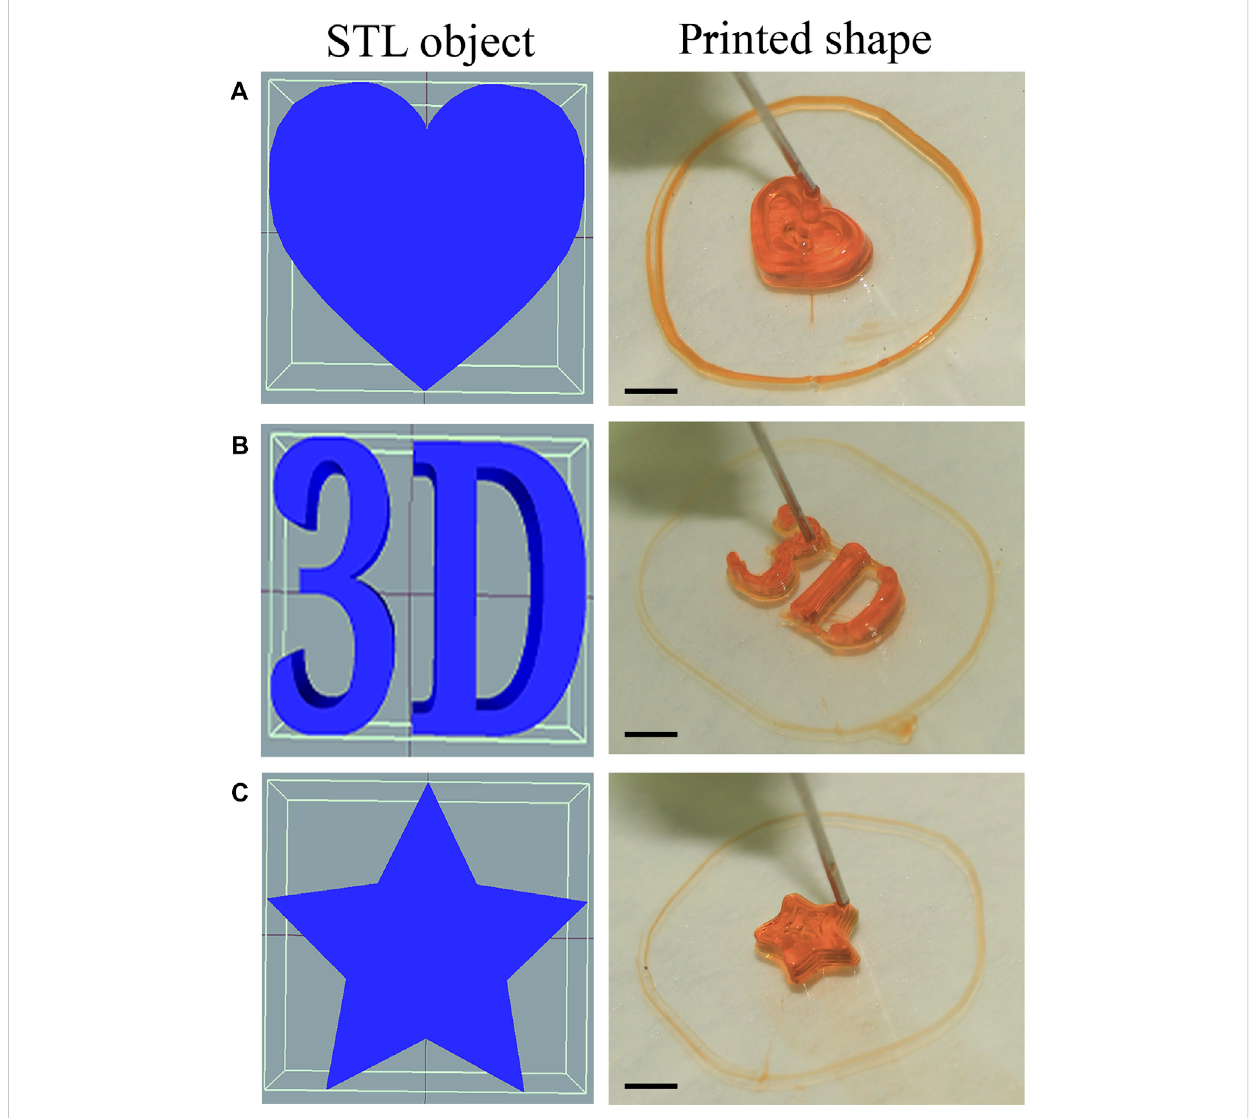
FIGURE 12 Accuracytestforresolutionoftheconstructsprintedbythebioprinteremployingthefollowing:ShapeprintedwithPluoronic-F12715%w/vwithout cells and employing food coloring. (A) Heart-shapedprint dimensions 3 mm × 6 mm × 8 mm (B) 3D-shaped print dimension 3 mm × 13 mm × 6.95 mm (C) Star-shaped print dimensions 2 mm × 6.18 mm × 7 mm. Right: rendering of models imported into RepetierHost, and Left: Printed shape from our prototype. Scale bar 1